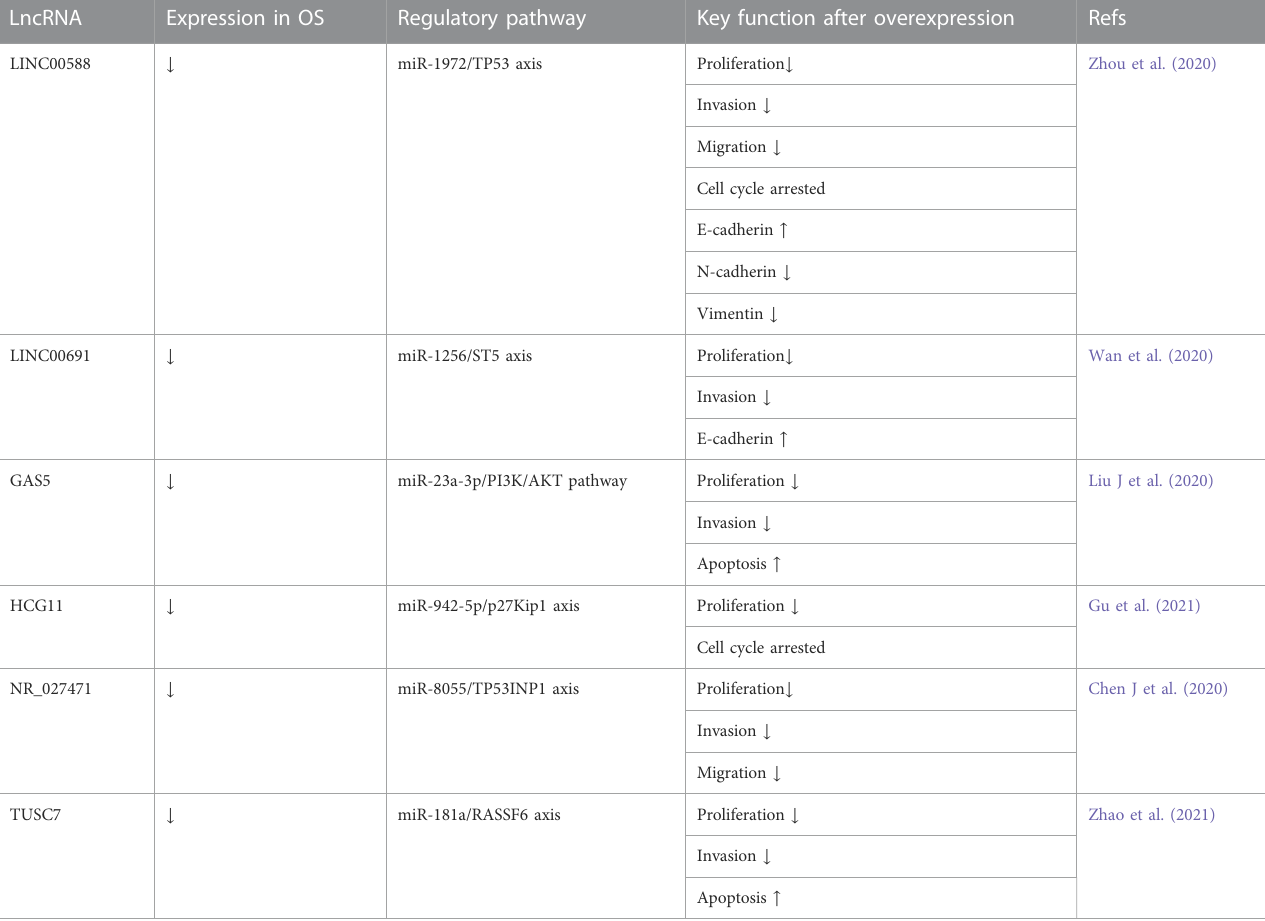
TABLE 7 Tumor suppressive lncRNAs associated with the inhibited progression of osteosarcoma targeting miRNA.